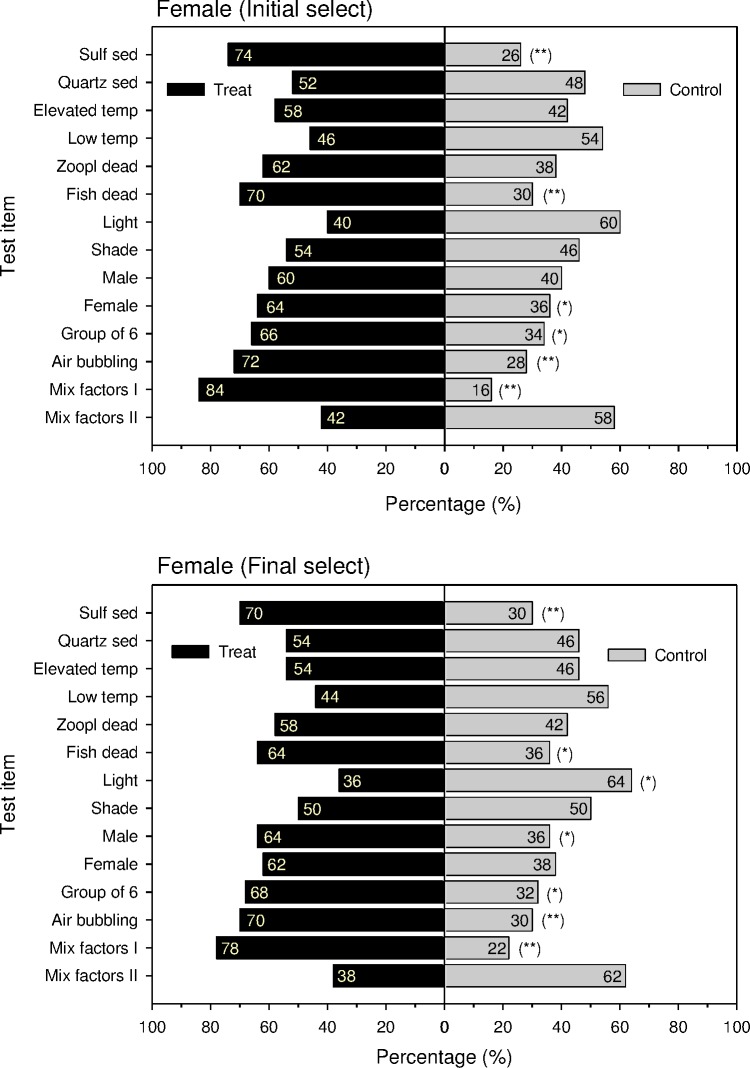
Binary choice of naive female Xenograpsus testudinatus in a binary-choice test.Response of initial selection and final selection. Numbers represent the percentage of selection behavior. * is p < 0.05; ** is p < 0.01; *** is p < 0.001.